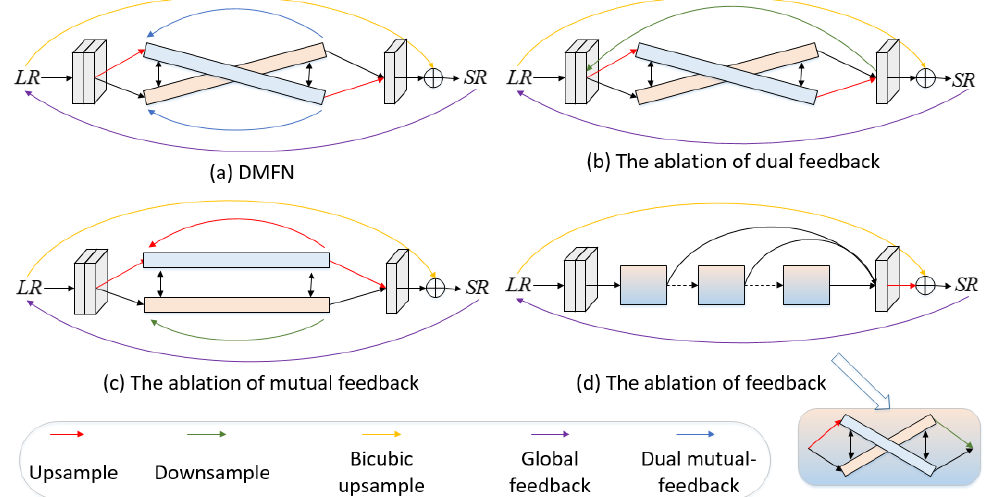
Figure 6. The ablation architectures. ( a ) is the DMFN. ( b ) represents the ablation of dual feedback. ( c ) represents the ablation of mutual feedback. ( d ) represents the ablation of